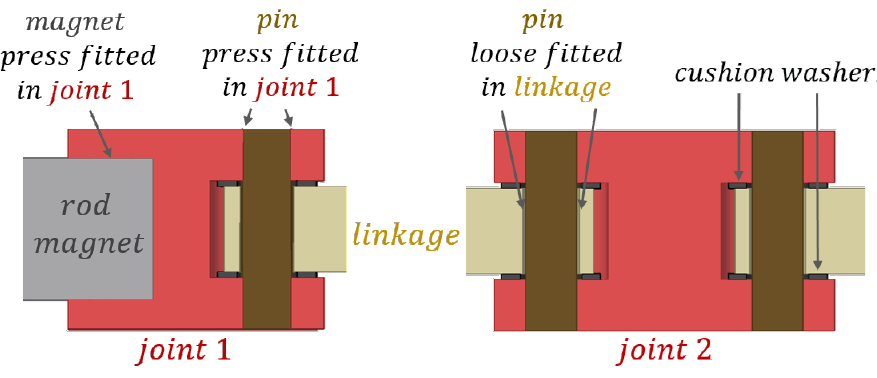
Figure 19. Cross sections of joint 1 and joint 2. These defined limits of angular rotation result in a possible range of motion, as illustrated in Figure 21, showing the range of motion from the side and top